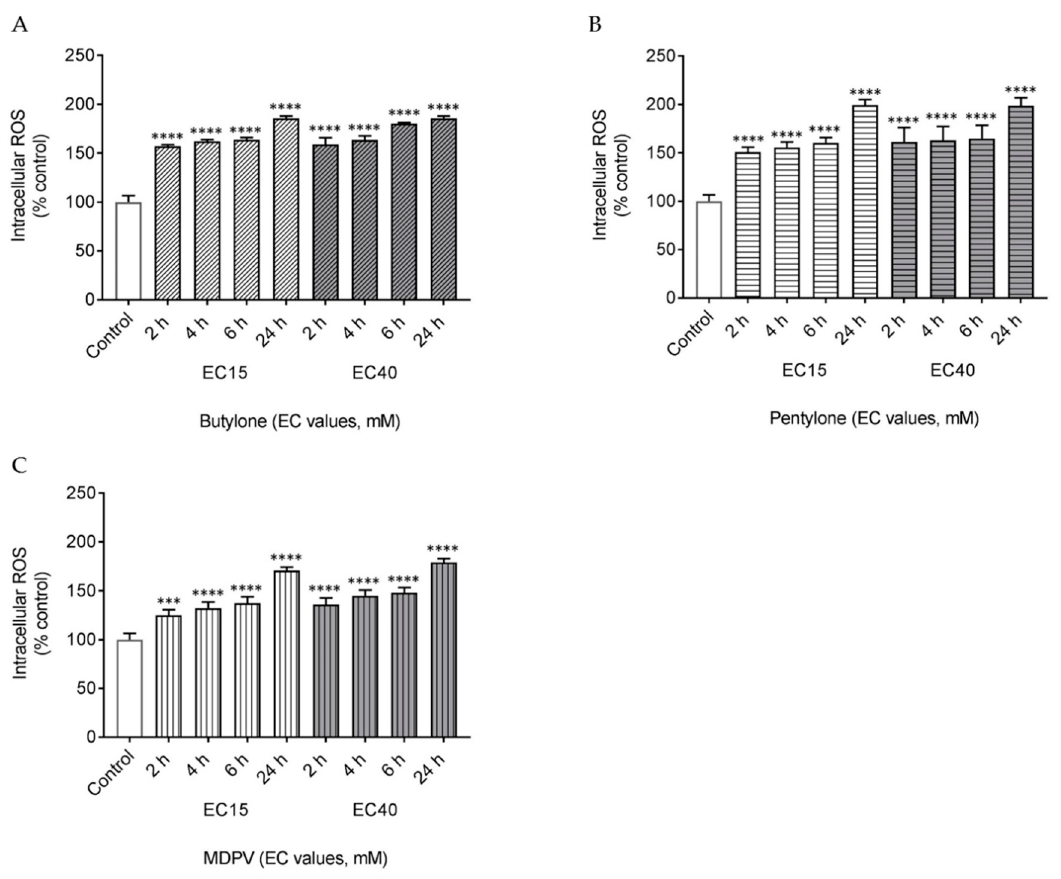
Figure 3. Intracellular levels of reactive oxygen species (ROS) after 2, 4, 6, and 24 h treatment of EC 15 and EC 40 for ( A ) butylone, ( B ) pentylone, and ( C ) MDPV. Data are Mean ± SD obtained from three independent experiments. Different to the control; **** p < 0.0001 and *** p < 0.001.